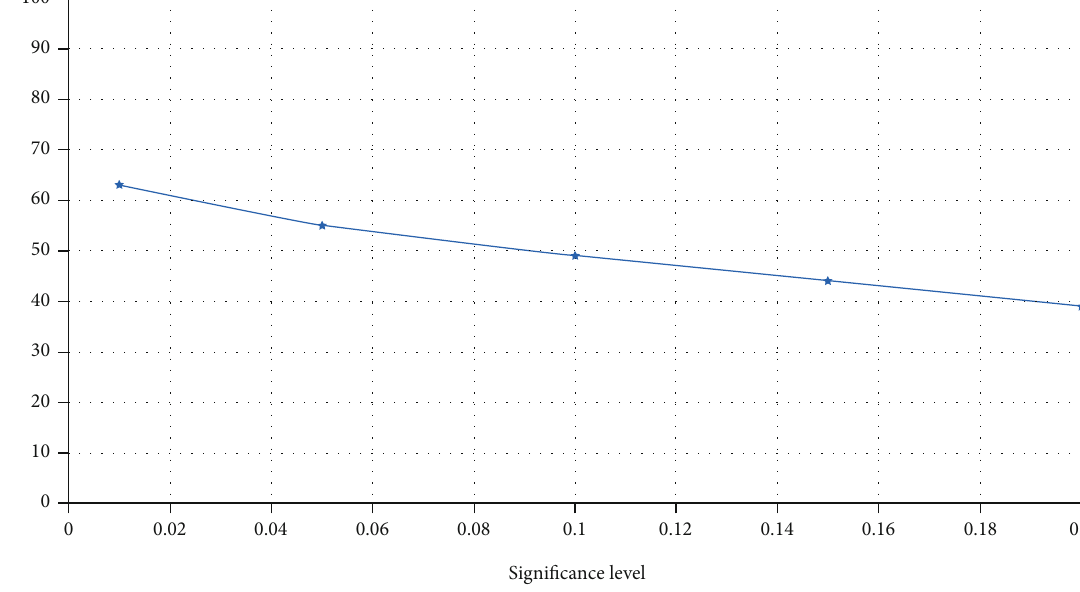
Figure 7: E ff ect of signi fi cance level on the number of detectors.